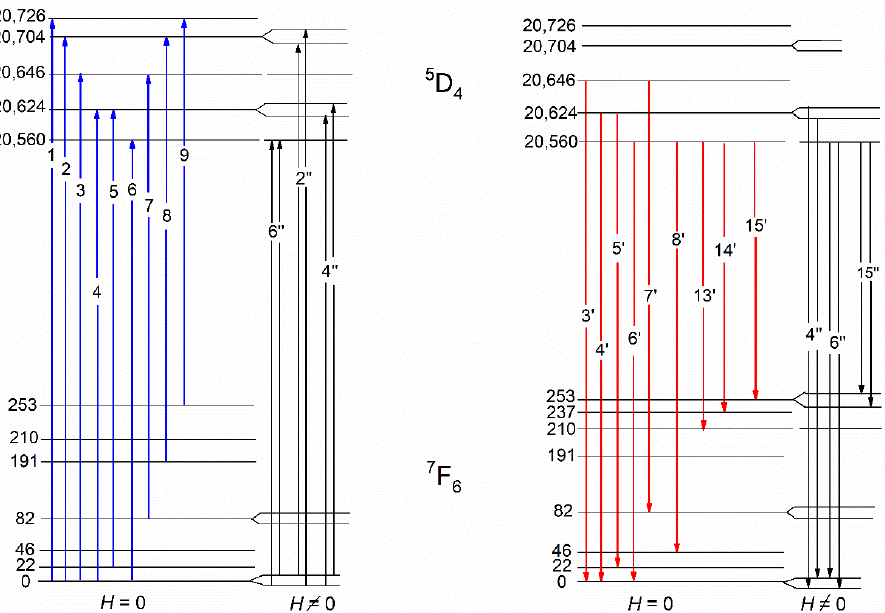
Figure 5. The scheme of Tb 3+ optical transitions in a KTF crystal, constructed according to the absorption (blue arrows) and PL (red arrows) spectra at T = 90 K. The diagrams of magnetically– optically active transitions in Tb 3+ ions, realized in the magnetic field H in the low-temperature spectra of MCD and MCPL, are shown on the right parts. Table 1. The energy E (cm − 1 ) of optical transitions between the ground 7 F 6 and excited 5 D 4 multiplets of the Tb 3+ ion observed in the absorption and PL spectra of the KTF crystal at T = 90 K.